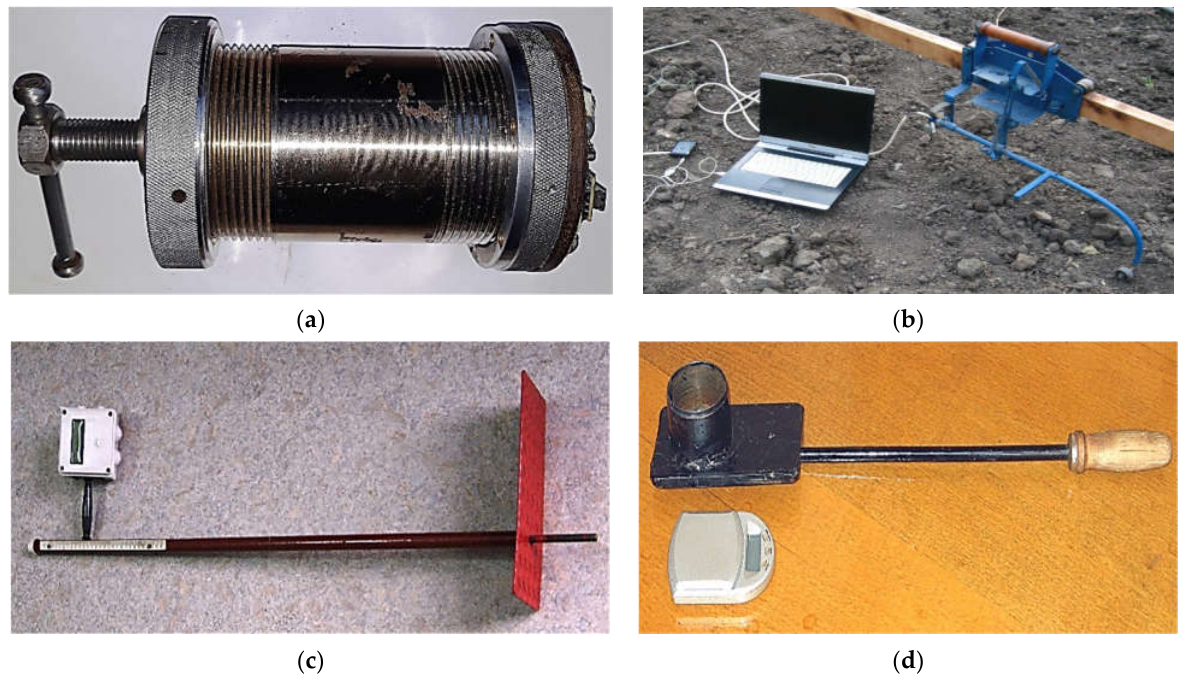
Figure 1. Devices for measuring soil moisture: ( a ) moisture content; ( b ) field surface profile; ( c ) ploughing depth; ( d ) soil bulk